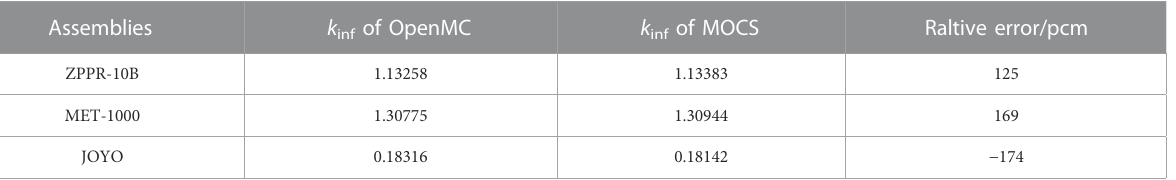
TABLE 1 The k inf results of different assemblies.